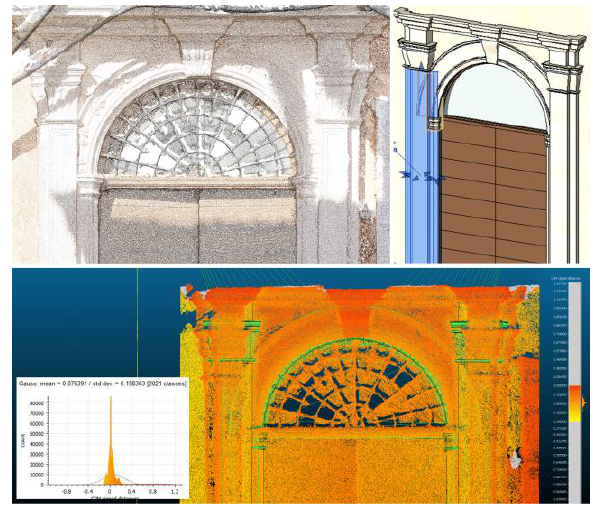
Figure 6. Geometric accuracy of the BIM model: deviation between the model of the main portal of Camponeschi palace and the point cloud (measurement performed within the CloudCompare